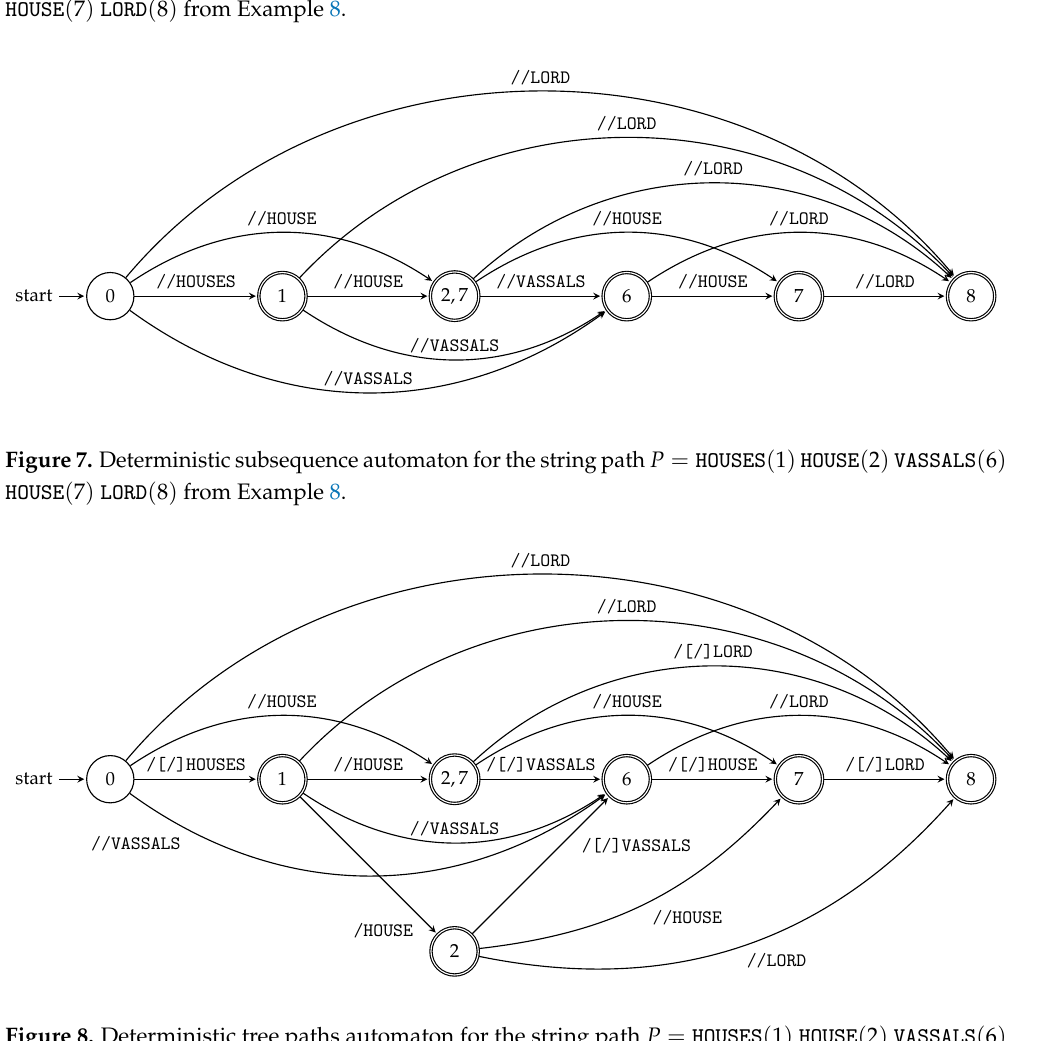
Figure 8. Deterministic tree paths automaton for the string path P = HOUSES ( 1 ) HOUSE ( 2 ) VASSALS ( 6 ) HOUSE ( 7 ) LORD ( 8 ) from Example